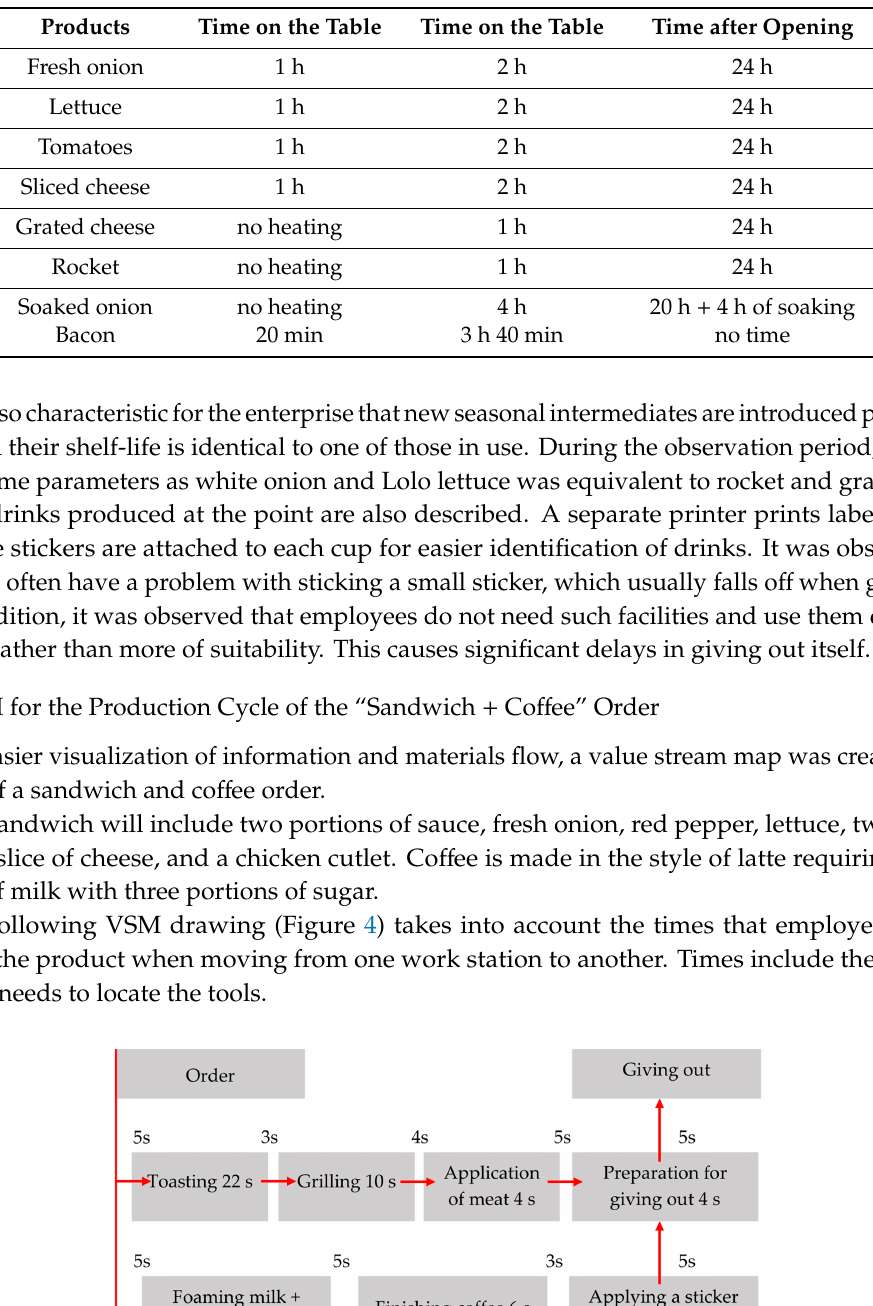
Table 2. Summary of shelf life of intermediate products.